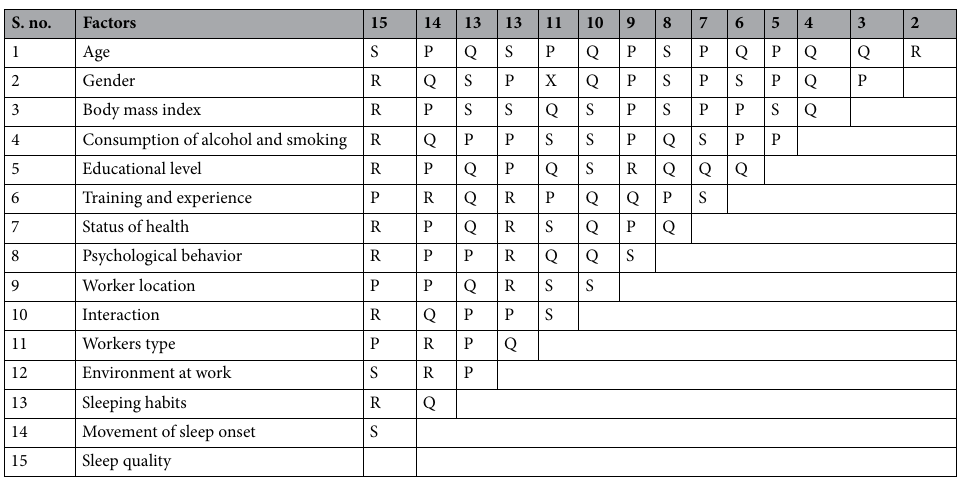
Table 3. A matrix of factors with structured self-interactions. P: Development function i causes (determines) development function j; Q: Development function i is caused (determined) by the development function j: R: Development functions i and j mutually cause (determine) each other; S: Development functions i and j are unrelated (independent).